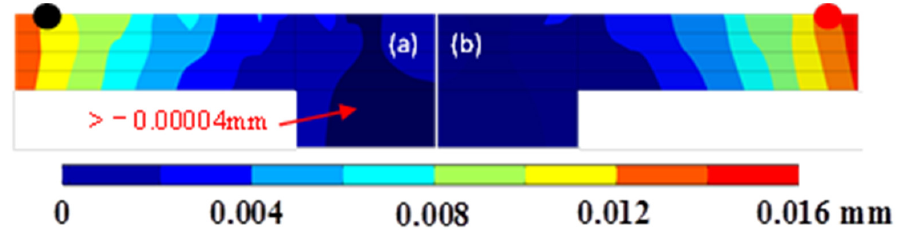
Figure 7. The final displacement distribution on the Y-Z plane (X = 0.495 mm). ( a ) Forming from the main body; ( b ) Forming from the overhang.